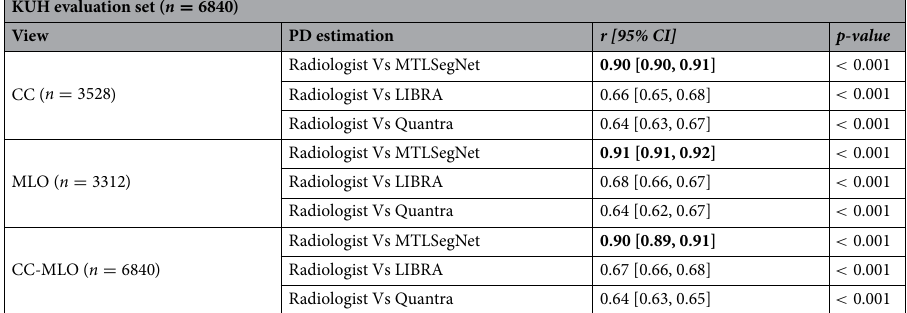
KUH evaluation set ( n = 6840